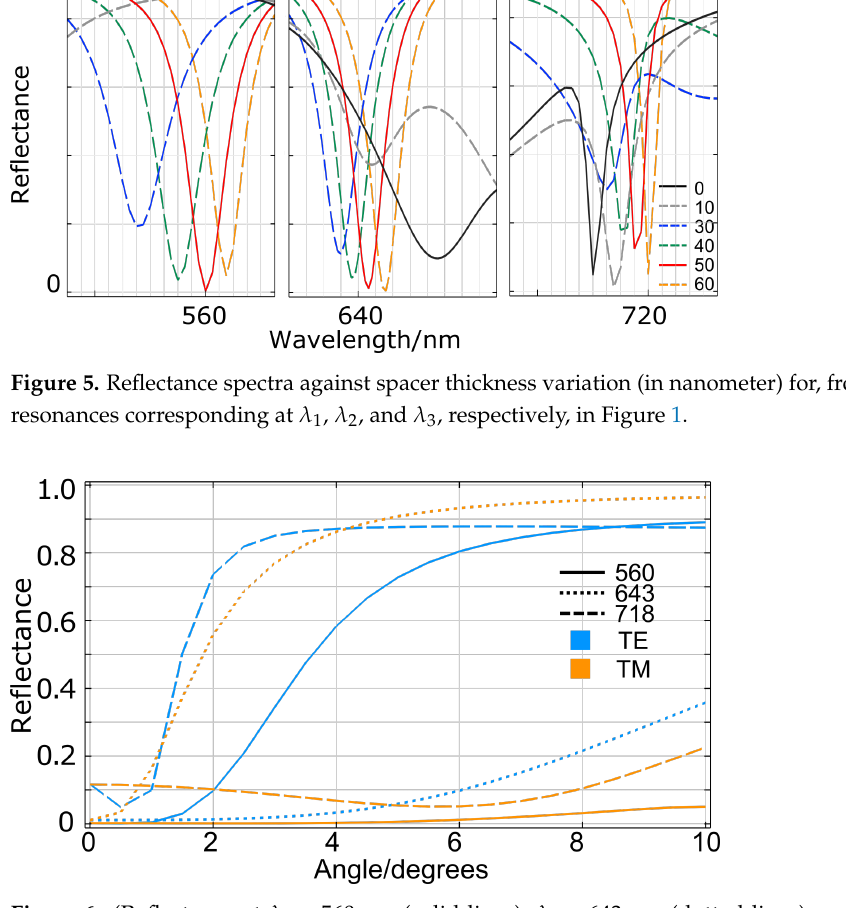
Figure 6. (Reflectance at λ 1 = 560 nm (solid lines), λ 2 = 643 nm (dotted lines), and λ 3 = 718 nm (dashed lines) with incident angle varying from 0 ◦ to 10 ◦ . Different colors distinguish TE (blue) and TM (orange)